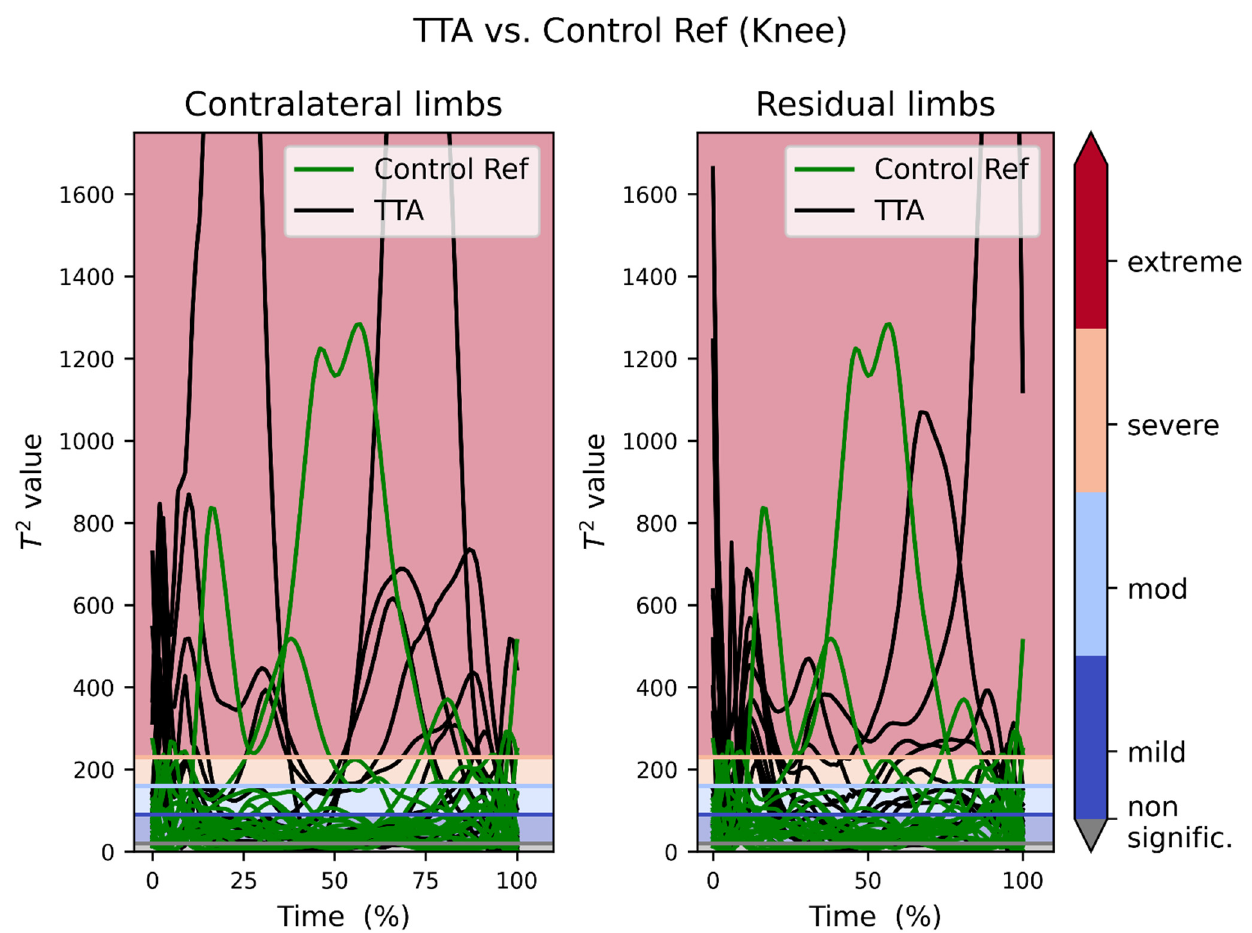
Figure 3. Transtibial amputation patients’ moments recording vs. reference recordings of the knee joint. The color scheme used for the horizontal lines is identical in all figures. The spiky tops of three curves are truncated for space limitation.